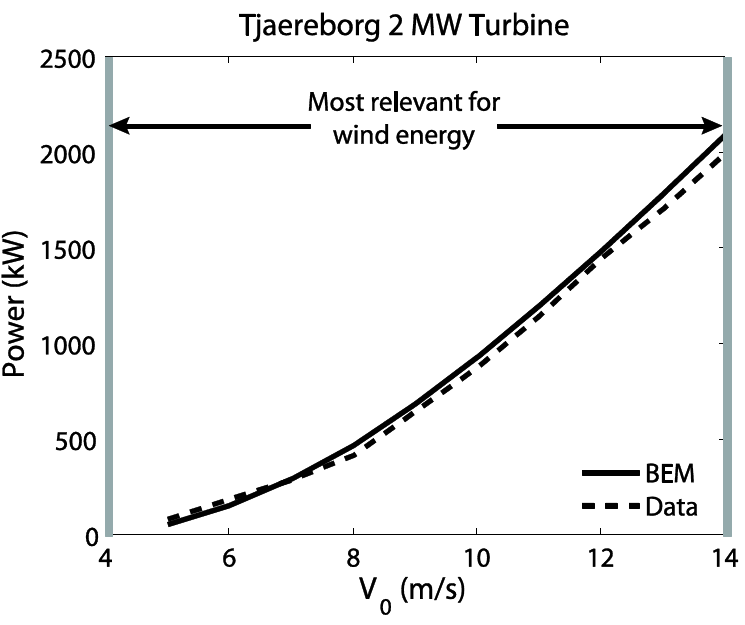
Figure 4. Tjaereborg power comparison as a function of wind